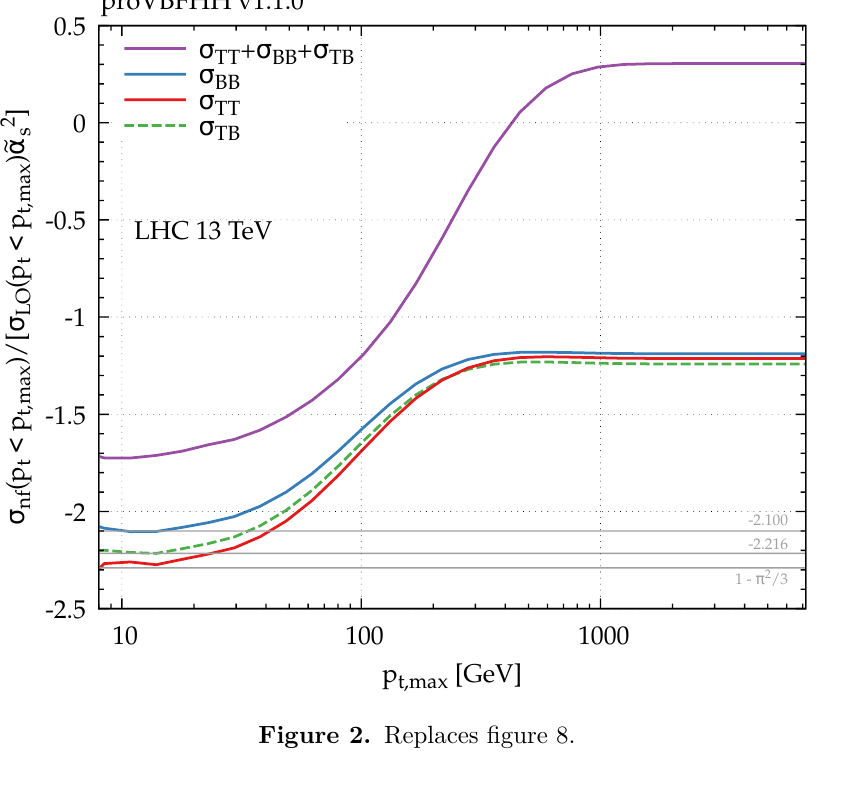
Figure 2. Replaces figure 8.